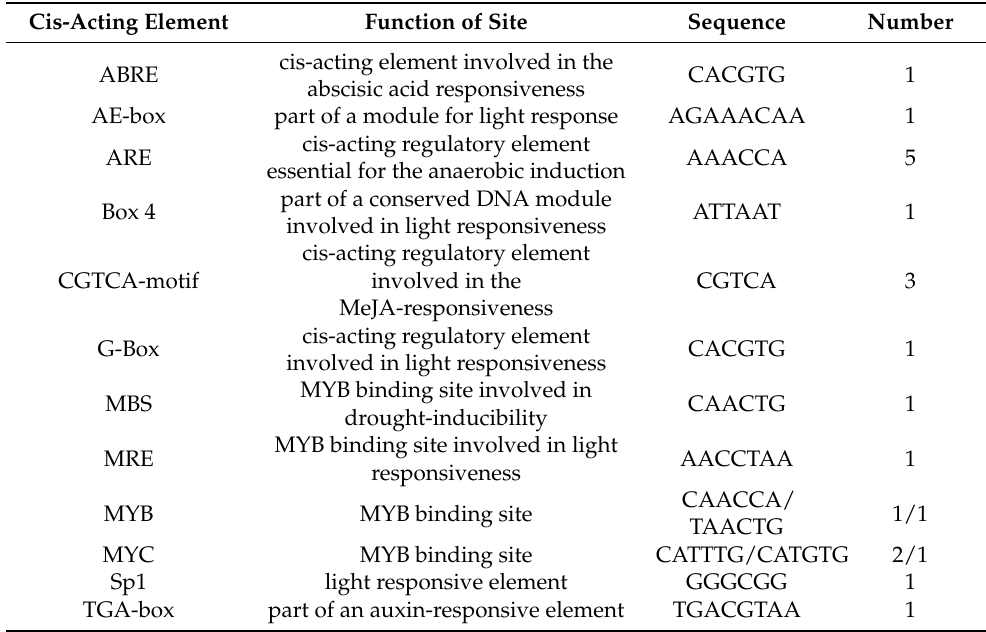
Table 1. The important cis-acting regulatory elements in the promoter sequence of FaWRKY71